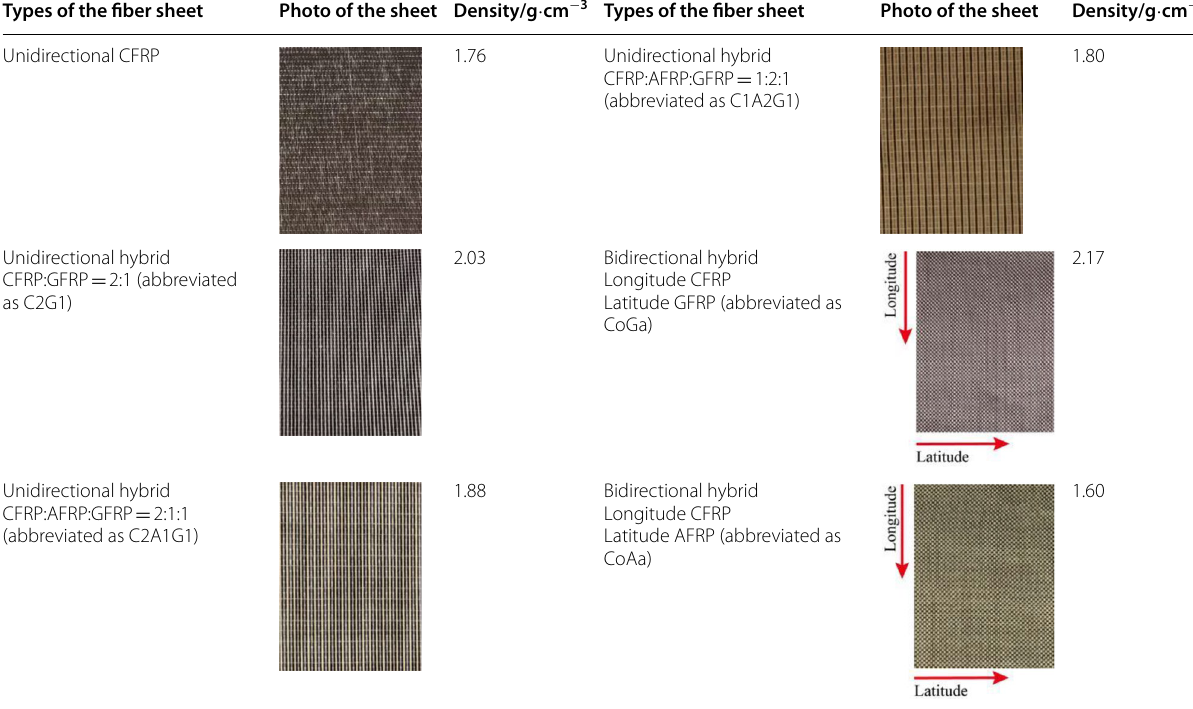
The fiber rayon density in both longitude and latitude directions is 6/cm